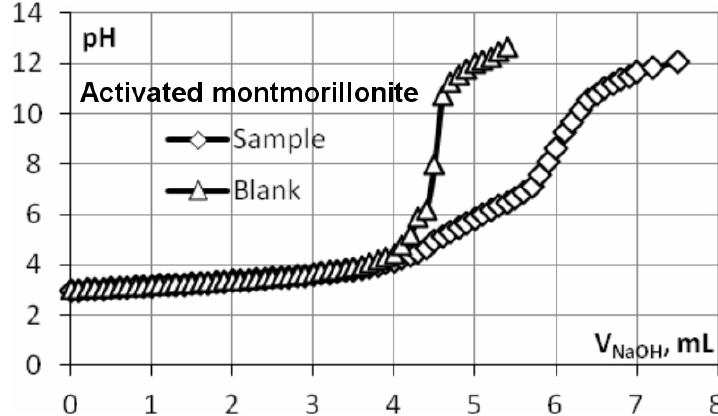
Figure 1. Potentiometric titration curves of activated montmorillonite.